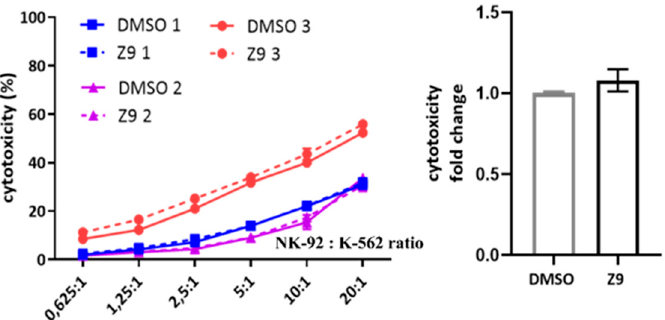
Figure 9. The effect of cathepsin X inhibition on NK-92 cell cytotoxicity. NK-92 cells were pre-incubated with DMSO or Z9 and brought into contact with CFSE-labelled K-562 target cells to initiate killing. Afterwards, the cells were collected, stained with viability dye 7-AAD and analysed by flow cytometry. The NK-92 cell cytotoxicity was determined by calculating the fraction of CFSE+/7-AAD+ events relative to all CFSE+ target cells, which was plotted against different effector to target cell ratios, to obtain the killing curves (left). From killing curves of three independent experiments, the lytic activity was calculated and normalized to DMSO control for comparison of relative change in cytotoxic activity of DMSO- vs Z9-treated NK-92 cells (right). The results represent the mean ± SD of the three independent experiments.